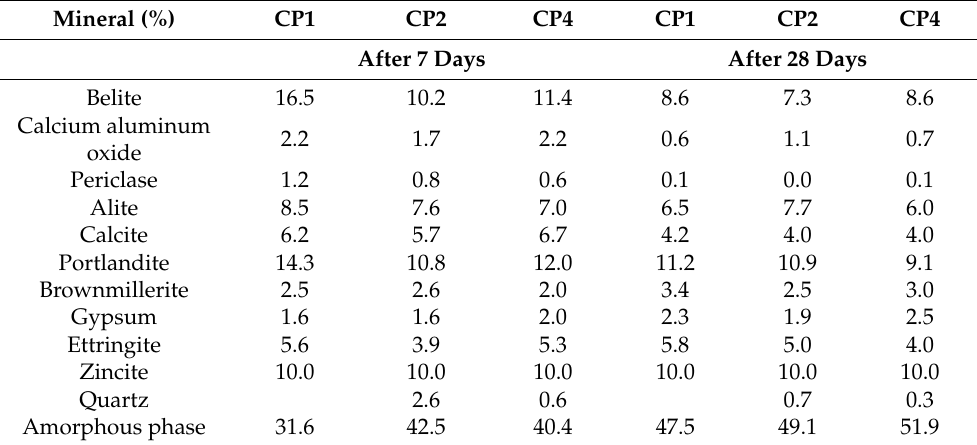
Table 4. XRD Rietveld test results.